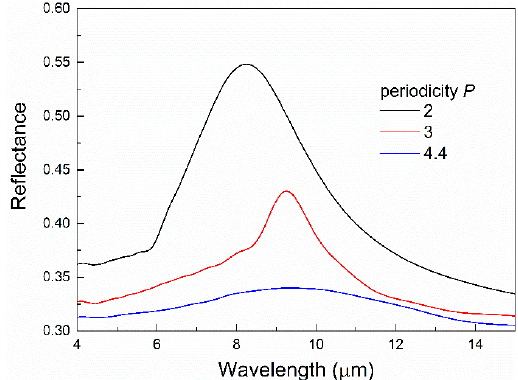
Figure 3. The effect of the periodicity P on the reflectance spectra of the disk arrays with D = 1 μ m.